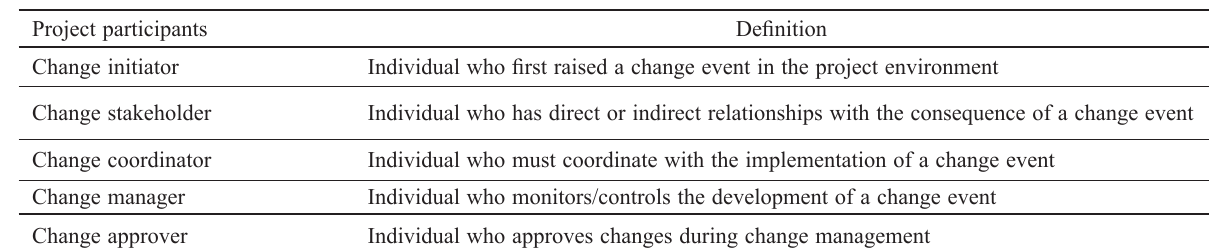
Table 3. Roles played by project participants in managing